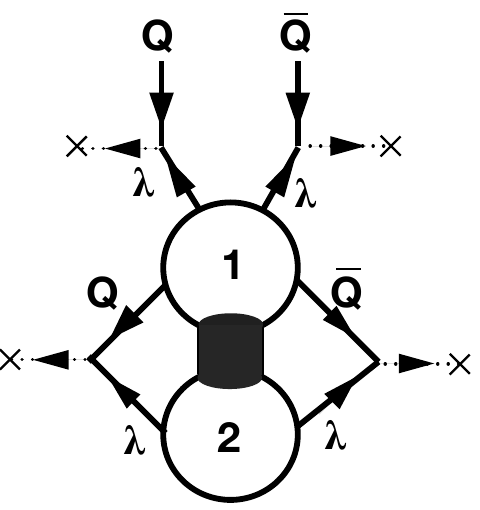
Figure 1 . Sketch of the multi-monopole contribution to the superpotential for SU(3) with a single (cid:13)avor. The dark cylinder connecting the two monopoles represents the (cid:13)ux tube con(cid:12)ning the two fundamental